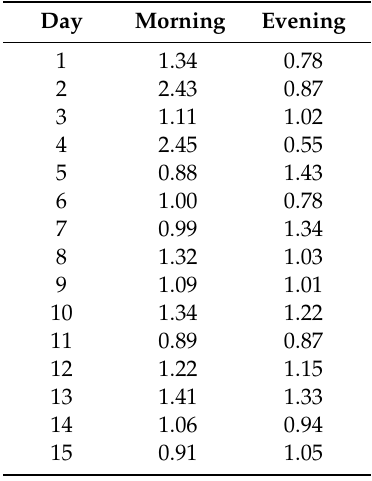
Table 1. Glucose measurement.